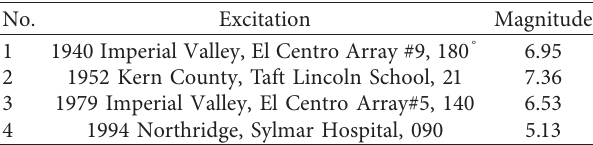
Table 1: Selected ground